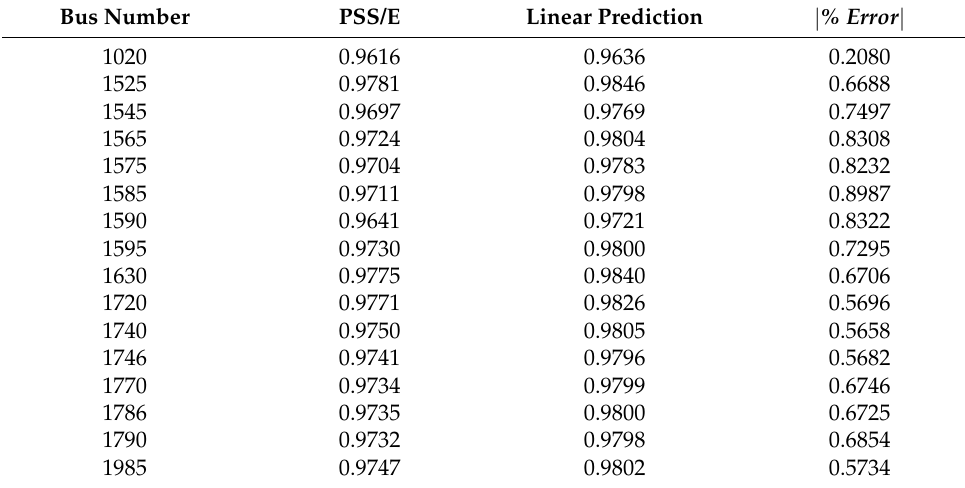
Table 4. Results of the linear prediction